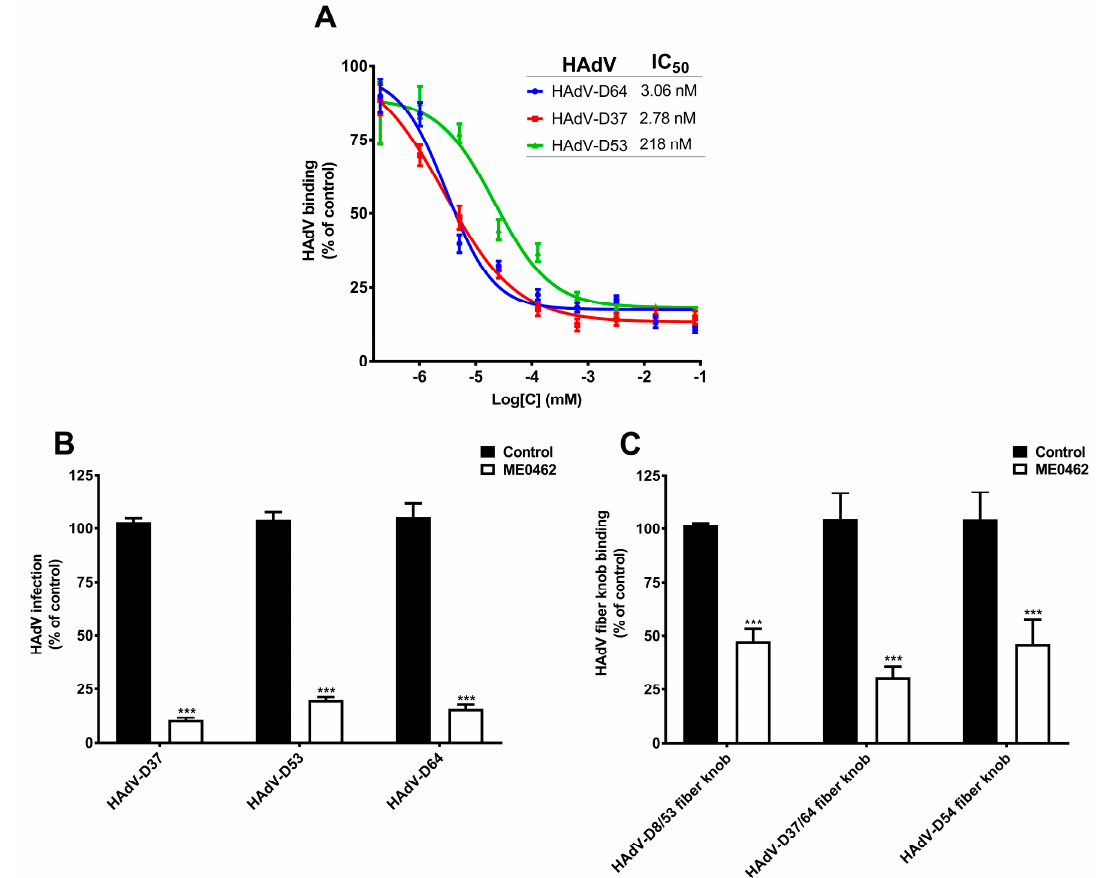
Figure 4. E ff ect of ME0462 on epidemic keratoconjunctivitis (EKC)-causing HAdVs binding to and infection of human corneal epithelial (HCE) cells. ( A ) Binding of 35 S-labeled HAdV-D37, -D53, and -D64, pre-incubated with increasing dose-dependent concentrations of ME0462, to HCE cells. ( B ) HAdV-D37, -D53, and -D64, pre-incubated with ME0462 (80 µ M), infection of HCE cells. ( C ) HAdV-D8 / 53, -D37 / 64, and -D54 fiber knobs, pre-incubated with ME0462 (80 µ M), binding to HCE cells. Error bars represent mean ± SEM. *** p < 0.001 relative to